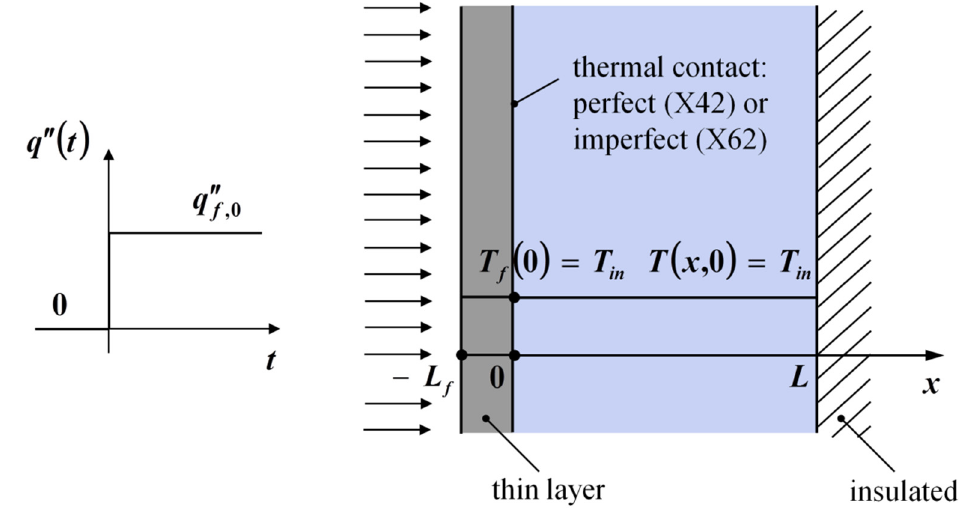
Figure 3. Schematic of the X42B10T11 problem.